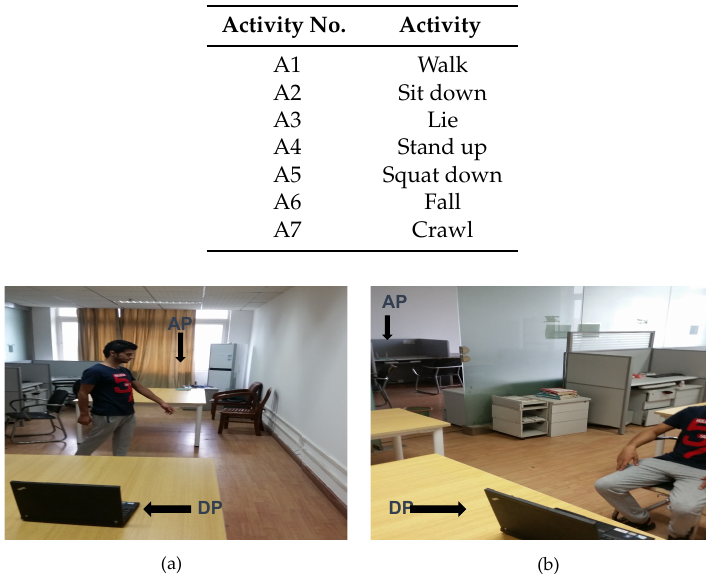
Table 1. The proposed activity description.